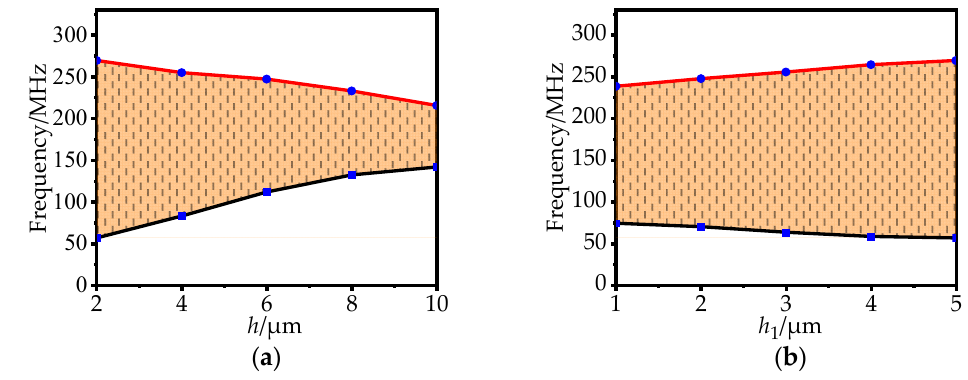
Figure 4. ( a ) The effect of h on the band gap; ( b ) The effect of h 1 on the band